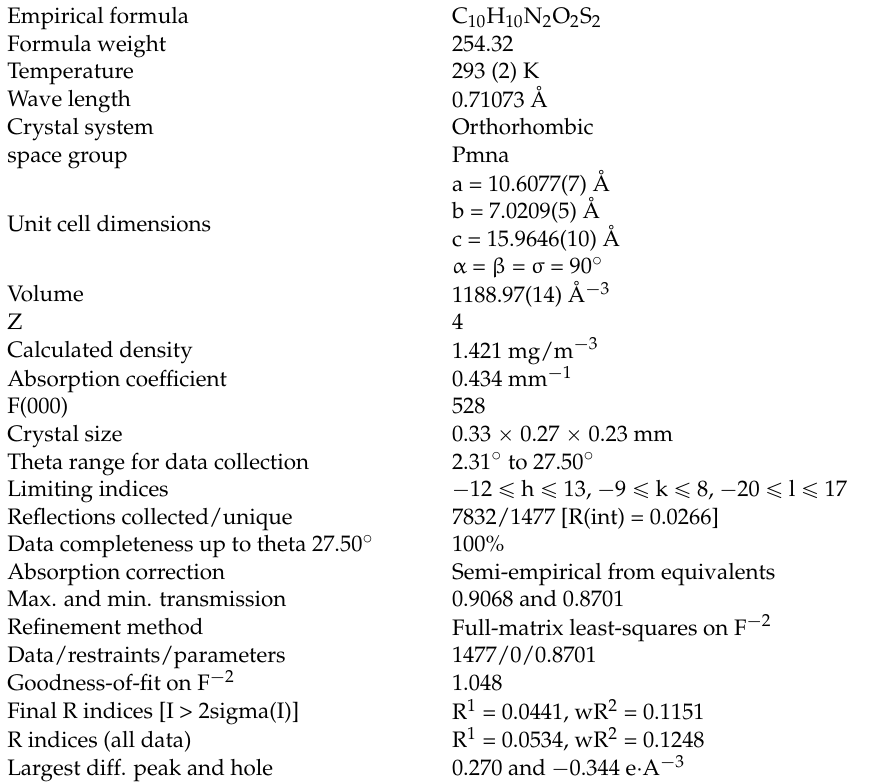
Figure 1. The ORTEP diagram of the final X-ray model of compound 4 with displacement ellipsoids drawn at 30% probability level. H-atoms were placed, and not included in refinement. Table 1. The crystal and experimental data of compound 4 .